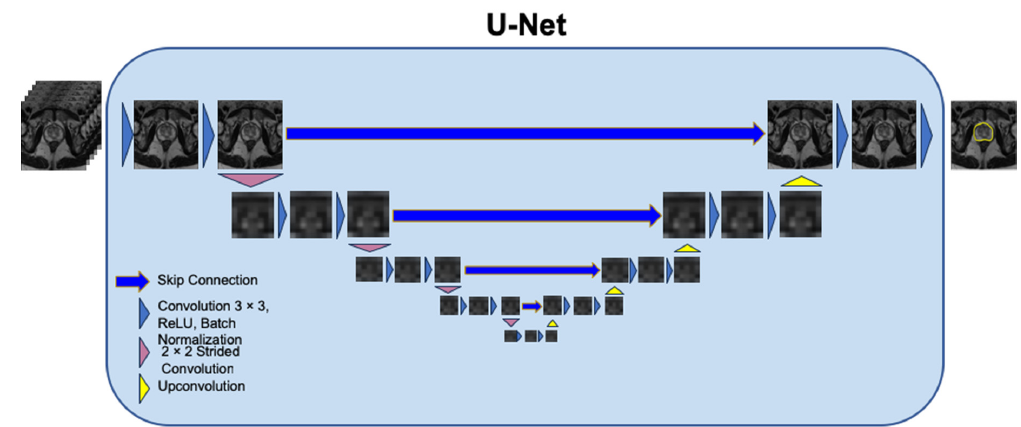
Figure 1. All neural network runs were completed on a U-Net with 5 layers. The number of channels used were 4, 8, 16, 32, and 32 for the 5 layers.